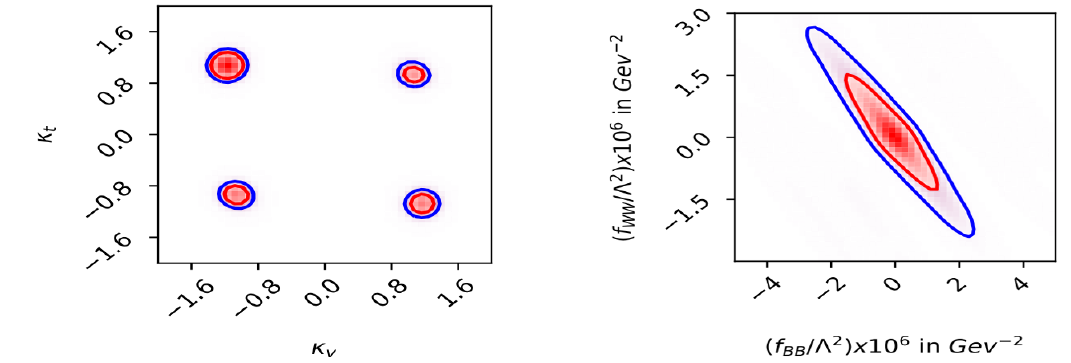
Figure 9 . Allowed regions at 1 (cid:27) (red) and 2 (cid:27) (blue) levels in the parameter space of scale factors and dimension-6 couplings in Type II 2HDM.